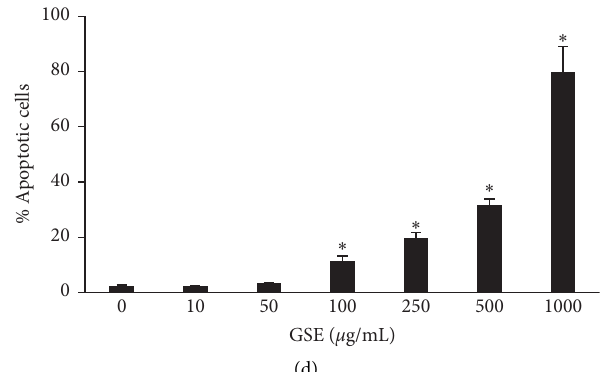
Figure 1: (a) Grammatophyllum speciosum . (b) Cell viability of human breast cancer MCF-7 cells. MCF-7 cells were treated with GSE at 0–1000 μ g/mL for 24h, and cell viability was investigated by MTT assay. (c) Level of apoptotic and necrotic cell death was determined by acridine orange/propidium iodine costaining assay after 24 h GSE treatment. (d) Percentages of apoptotic cells were analyzed. Data represent the mean ± SD ( n � 3). ∗ Significantly different at p < 0 . 05 versus nontreated